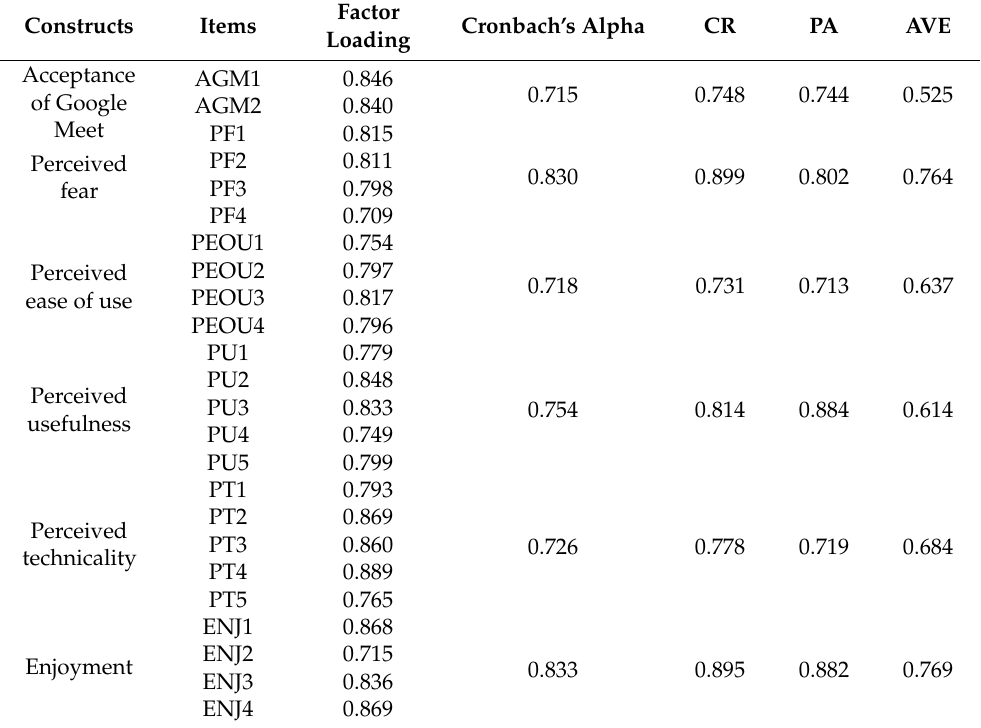
Table 5. Convergent validity results which assure acceptable values (factor loading, Cronbach’s alpha, composite reliability (CR), Dijkstra-Henseler’s rho (PA) ≥ 0.70 and the average variance extracted (AVE) >